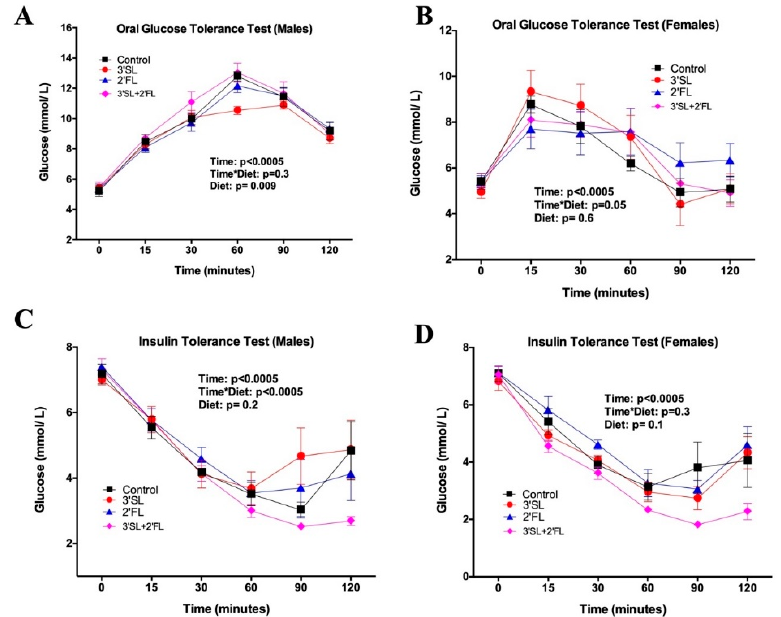
Figure 2. Oral glucose tolerance test (OGTT) in ( A ) male and ( B ) female rats; insulin tolerance test (ITT) in ( C ) male and ( D ) female rats fed the AIN-93 diet fortified with 3 (cid:48) SL, 2 (cid:48) FL, both, or neither for eight weeks. Values are means ± SEM, n = 8–10. In the overall model, there was a significant sex e ff ect for OGTT ( p = 0.001); therefore, subsequent analysis was performed in males and females separately. Control: AIN-93; 3 (cid:48) SL: AIN-93 + 3 (cid:48) sialyllactose; 2 (cid:48) FL: AIN-93 + 2 (cid:48) fucosyllactose; 3 (cid:48) SL + 2 (cid:48) FL: AIN-93 + 3 (cid:48) sialyllactose + 2 (cid:48) fucosyllactose. Significance was set at p <